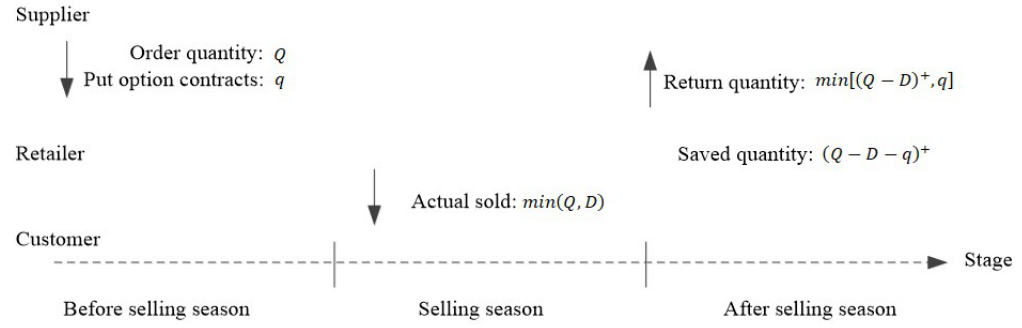
Figure 2. Flexible return strategy with the put